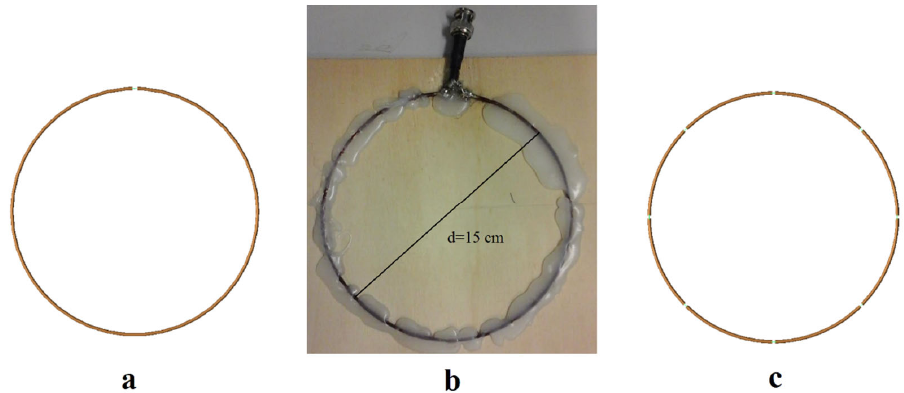
Figure 1. The investigation coil under investigation: ( a ) non ‐ segmented simulated loop; ( b ) non ‐ segmented home ‐ built prototype loop; ( c ) n = 8 ‐ segment simulated loop .